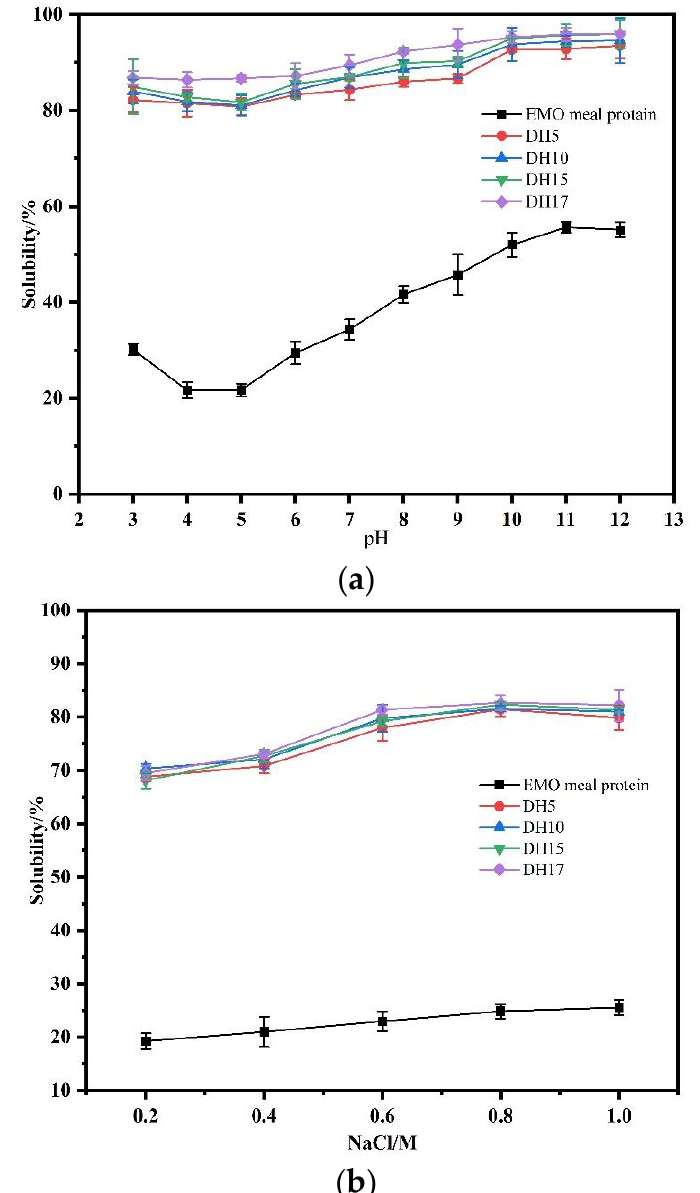
Figure 6. Effect of pH ( a ) and NaCl content ( b ) on the solubility of the EMO meal protein and hy- drolysates.